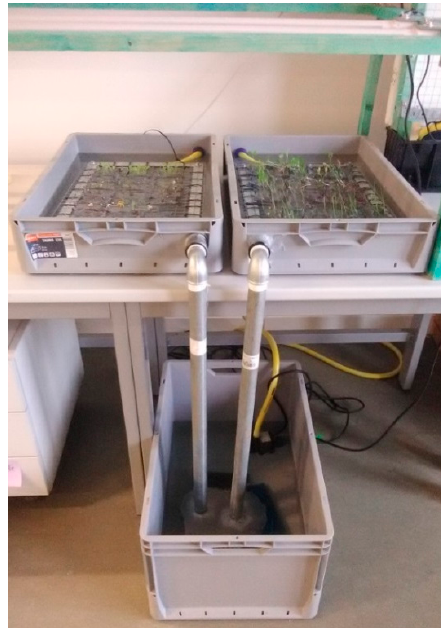
Figure 1. Hydroponic test stand used in this study.